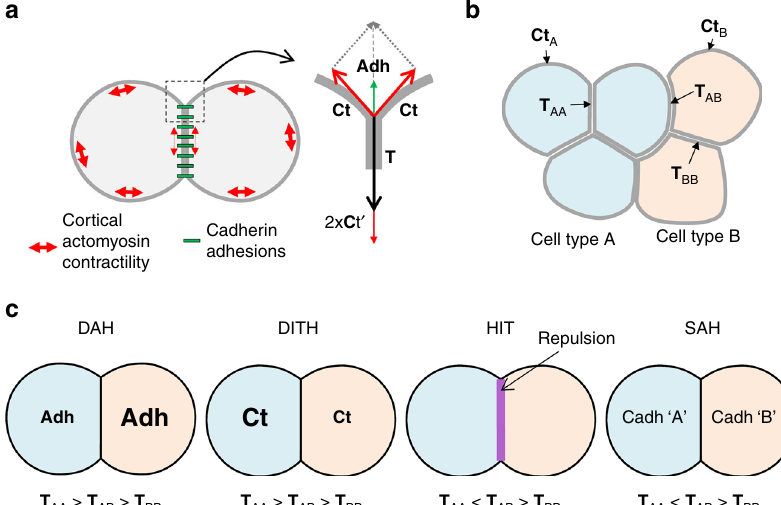
Fig. 1 Contact tension and cell sorting. a Diagram of two adhering cells and representation of the force equilibrium at a contact vertex. The cadherin adhesive structures are represented in green , and the contractility of the actomyosin cell cortex by red double arrows . Note that cadherin adhesions in fl uence the cell cortex, decreasing tension along contacts ( smaller double arrows ). The equilibrium of forces at a vertex involves the cortical tension Ct at the free surface of each cell and the contact tension T between the two cells. T is the sum of the two cortical tensions at the contact ( Ct ′ ) and of cell – cell adhesion ( Adh ), which acts in the opposite direction to expand the contact. b Contact tensions in tissues. T AA and T BB represent tensions at homotypic contacts. T AB represents the contact tension at heterotypic contacts, also called here interfacial tension. c Comparison of the four models for cell sorting and separation based on contact tensions. In the differential adhesion hypothesis ( DAH ) and the differential interfacial tension hypothesis ( DITH ), the two cell populations have different homotypic tensions, and the heterotypic tension is intermediate. Repulsive mechanisms such as those generated by ephrin-Eph signalling generate high interfacial tension ( HIT ). The same situation can be achieved in the selective adhesion hypothesis ( SAH ), due to preferential homotypic cadherin